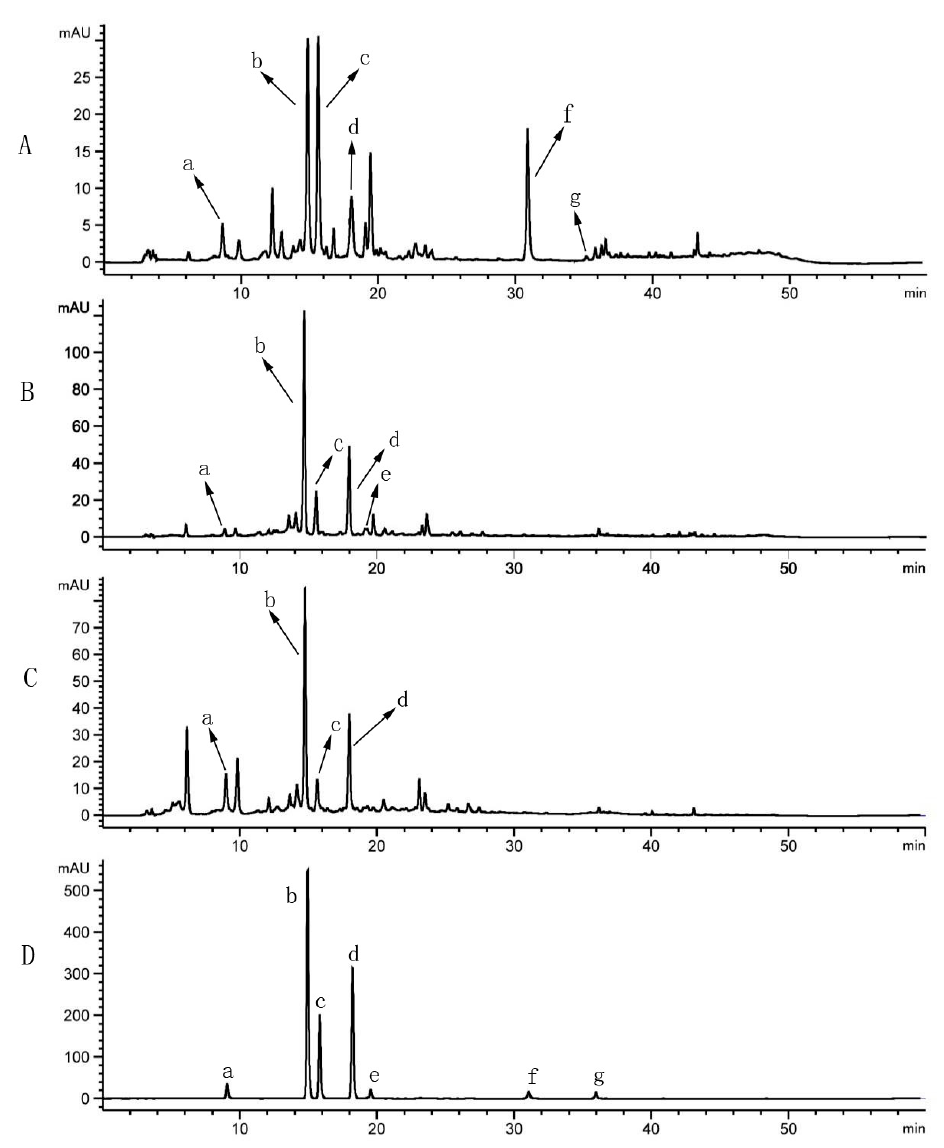
Figure 1. HPLC chromatograms of sample solution and standards. Lophatherum gracile (LG, No. 2) leaf-extracts ( A ), Pleioblastus amarus (PA, No. 8) leaf-extracts ( B ), Phyllostachys nigra (PN, No. 21) leaf-extracts ( C ), and seven mixed reference standards (a, b, c, d, e, f, g) ( D ).